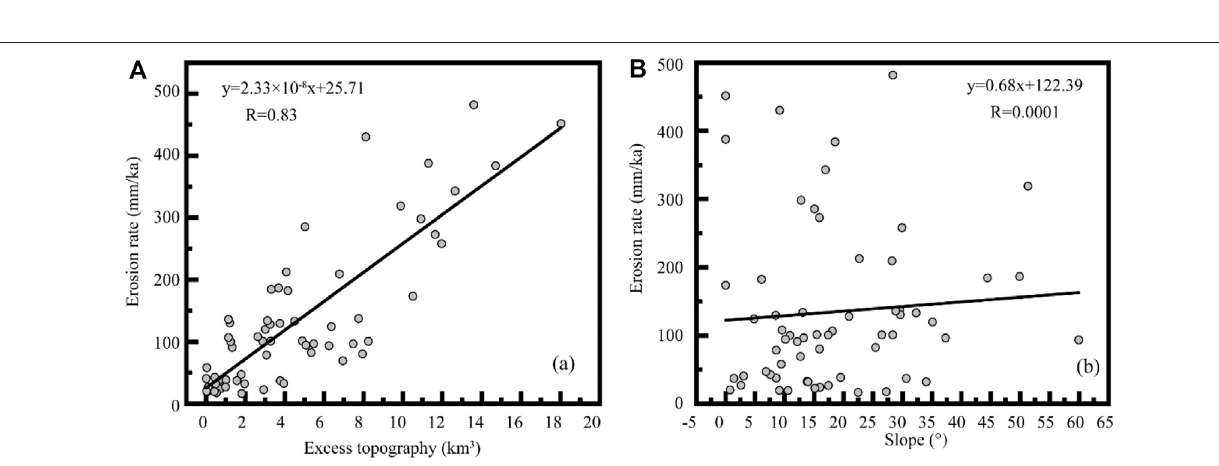
Frontiers in Earth Science |